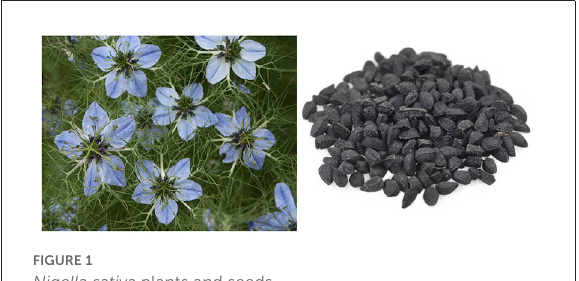
FIGURE1 Nigella sativa plants and seeds.